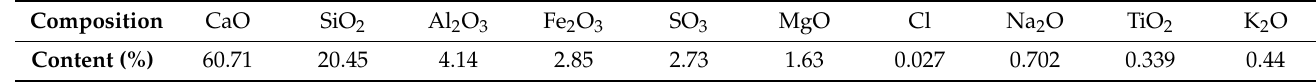
Table 1. Chemical composition of cement.